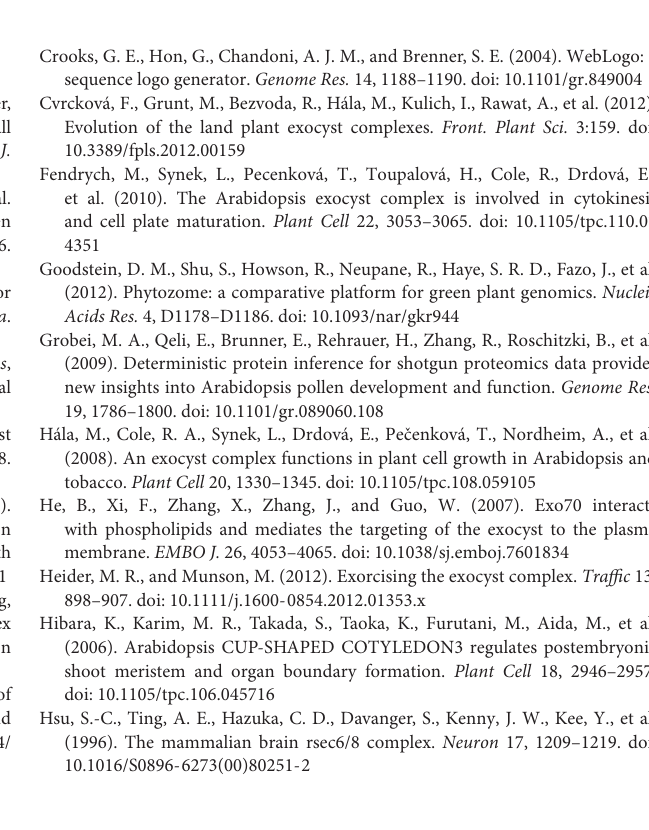
Supplementary Figure 1 | Multiple protein alignment of angiosperm EXO70C family and all EXO70 paralogs from Arabidopsis. Supplementary Figure 2 | Yeast two-hybrid interaction assay for EXO70C2 and ROH1 members. Interaction assay of two different members of the Arabidopsis ROH1 family (ROH1A and ROH1D) and the Arabidopsis exocyst EXO70C2 subunit in its WT, phospho-mimetic (PM) and phospho-dead (PD) variants performed under stringent conditions (A) . Corresponding transformation controls are shown in (B) . Supplementary Figure 3 | EXO70C2 is specifically expressed in domain surrounding shoot apical